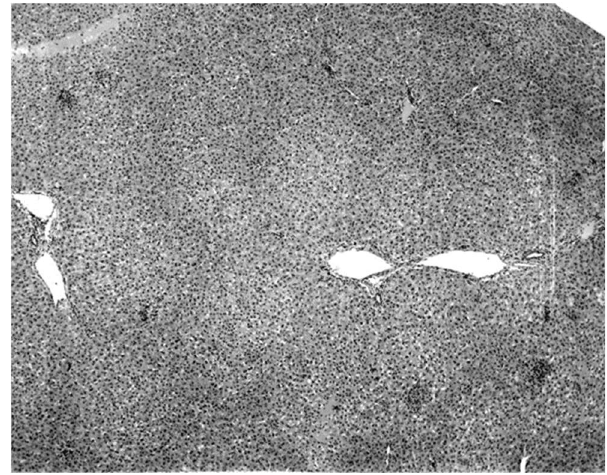
Figure 4. Acute multi-focal hepatitis observed in wrinkle-lipped free-tailed bats experimentally-infected with KKV.